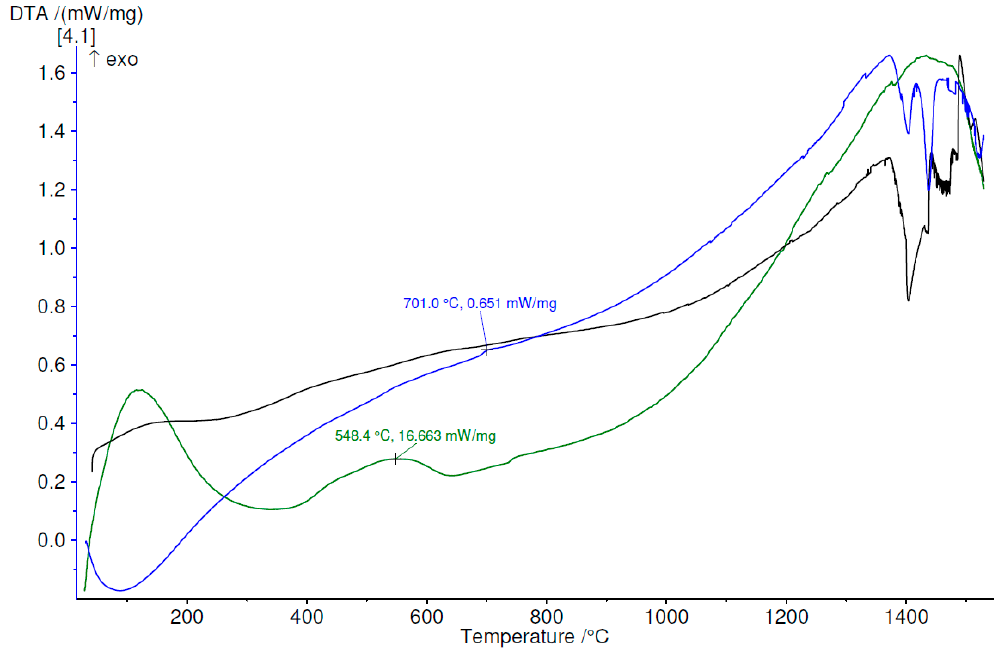
Figure 19. DTA variation as a function of temperature, up to 1530 ◦ C, for Ti 60 Zr 10 Si 15 Nb 15 alloy, bulk (black) and melt-spun ribbons (green—MS1,